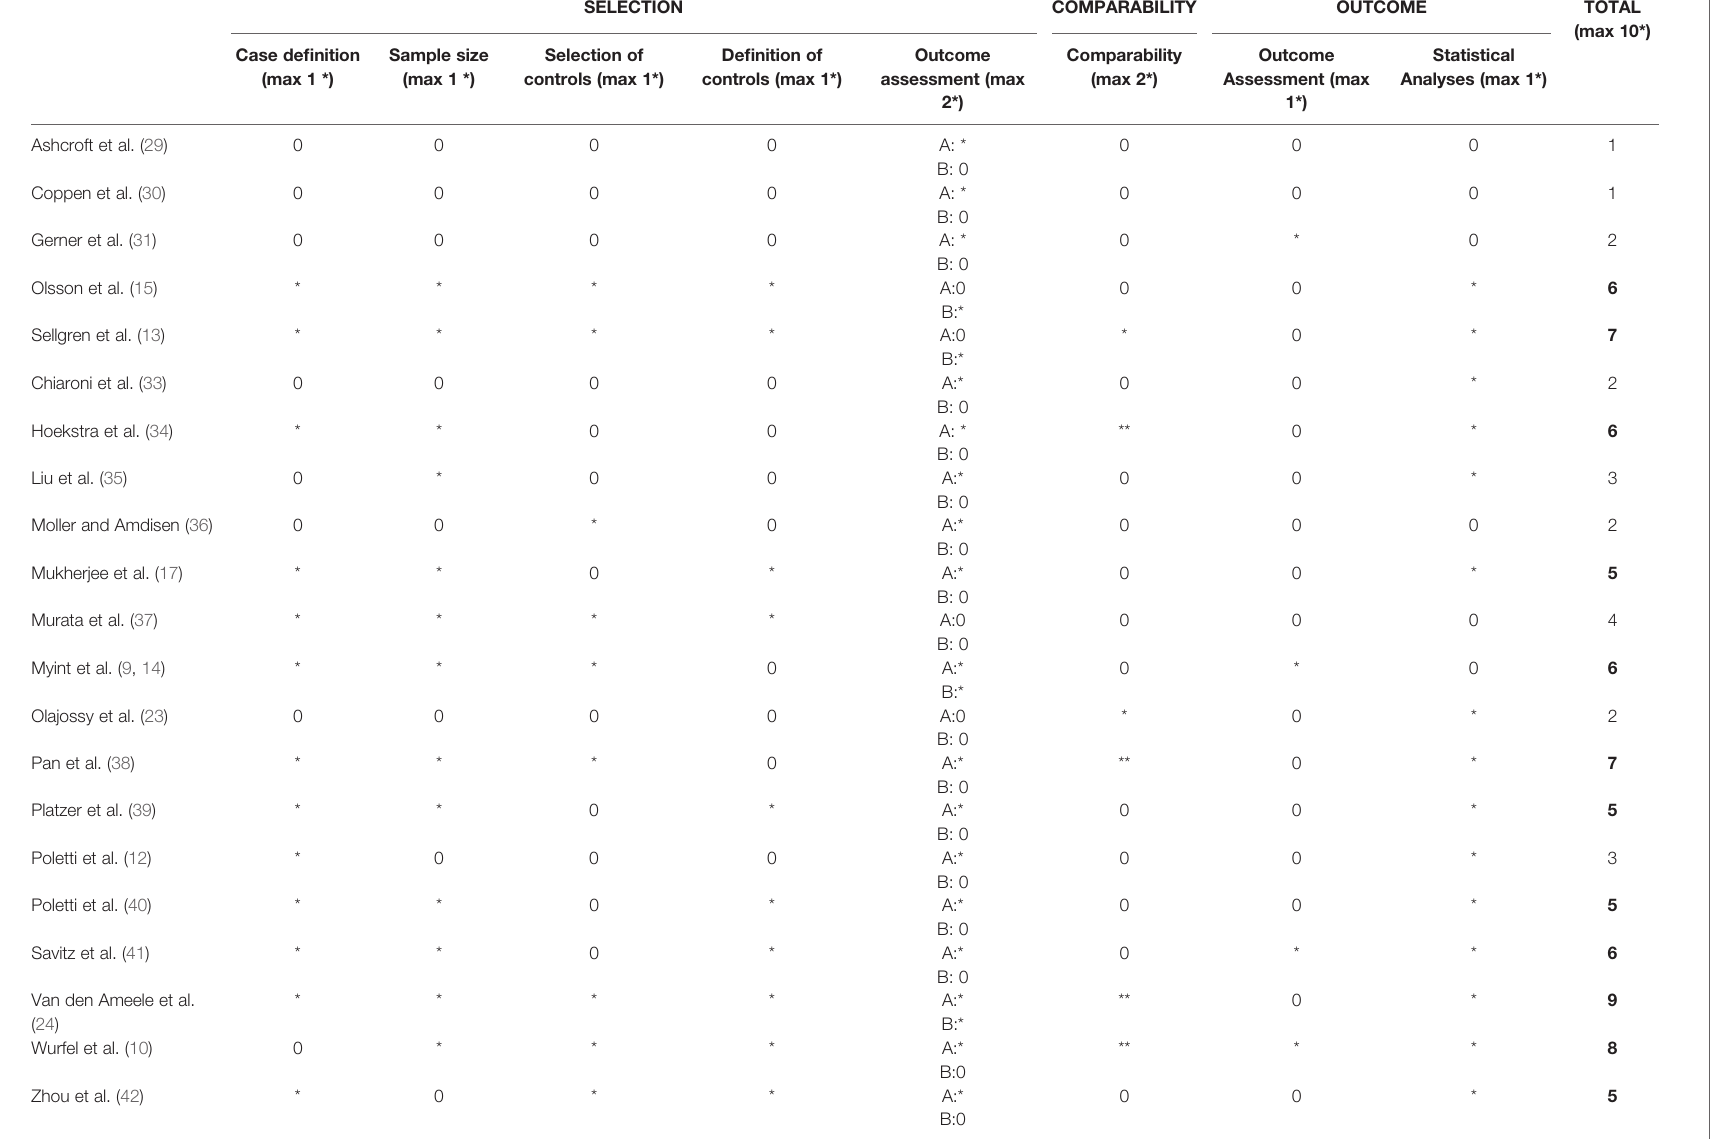
TABLE 2 | Quality